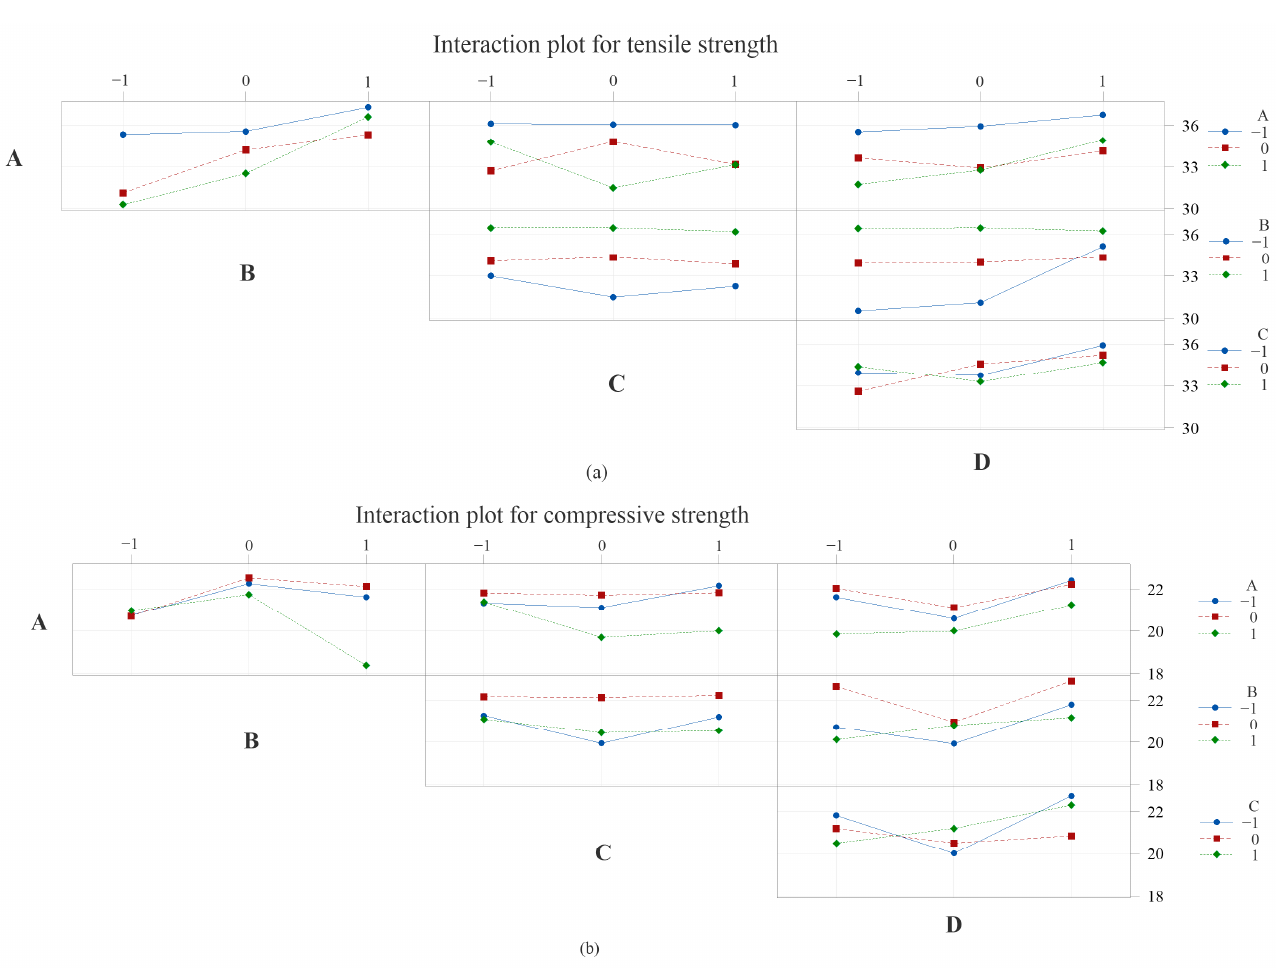
Figure 5. Interaction plot for mechanical strength by Taguchi method: ( a ) tensile; ( b ) compressive.